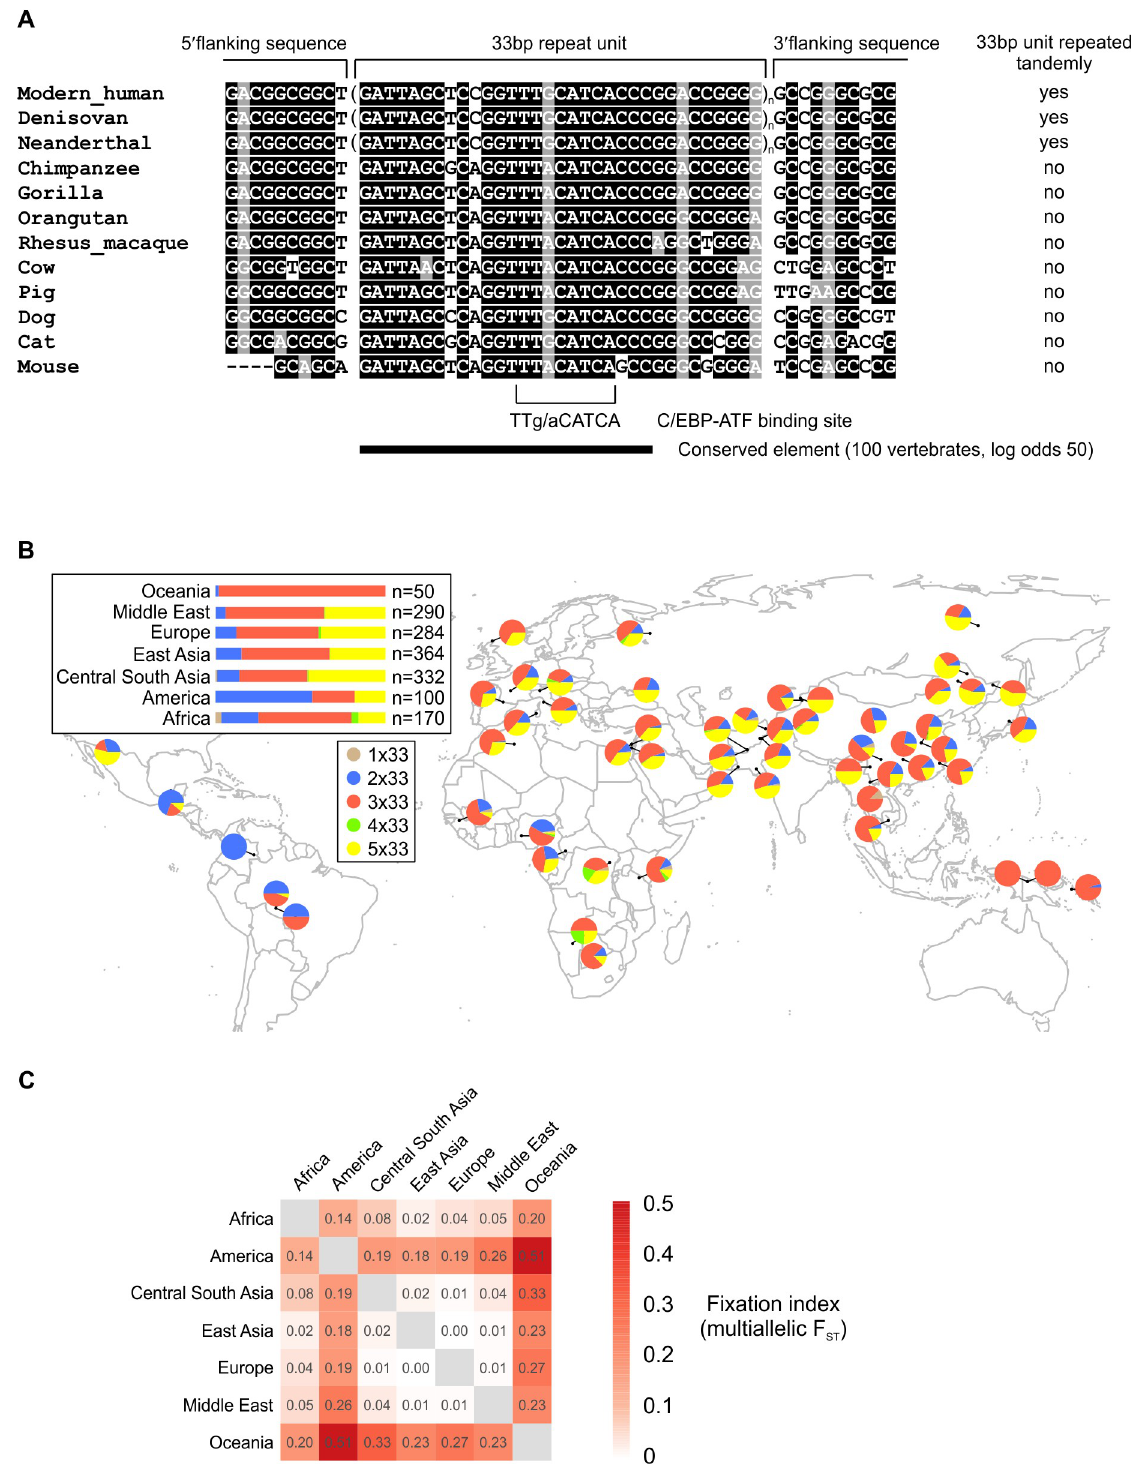
Fig 2. Evolutionary conservation of the TRIB3 promoter 33-bp VNTR area across mammalian species and the geographical distribution of the TRIB3 33-bp VNTR alleles in human populations. (A) Nucleotide sequence alignment of the human TRIB3 promoter 33-bp VNTR repeat unit and flanking areas with the corresponding sequence in various mammalian genomes. Only one copy of the repeat is shown for modern human and Denisovan and Neanderthal hominins. Alignment was produced using Clustal Omega and Boxshade, with identical nucleotides shown in black and conserved purines in grey. The location of the C/EBP-ATF binding site is highlighted, overlapping